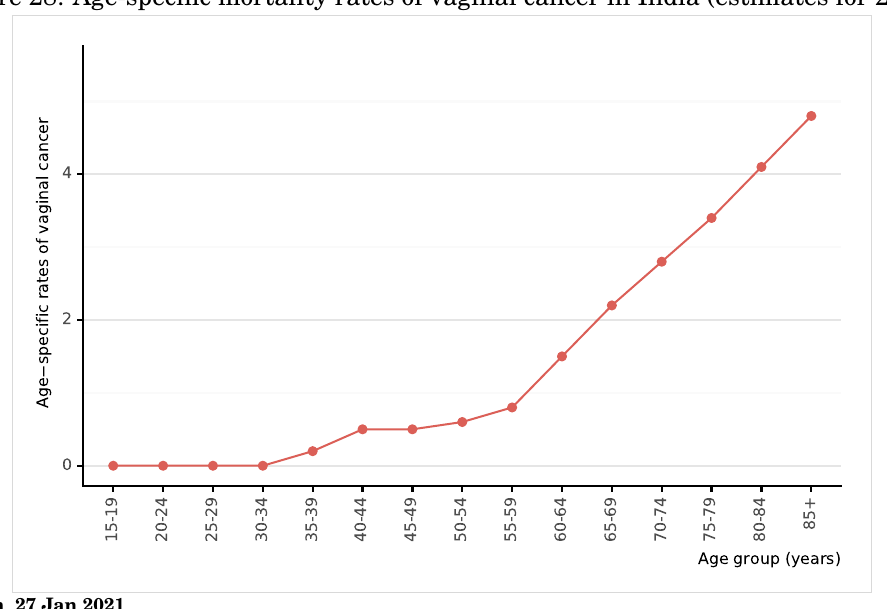
Figure 28: Age-specific mortality rates of vaginal cancer in India (estimates for 2020)